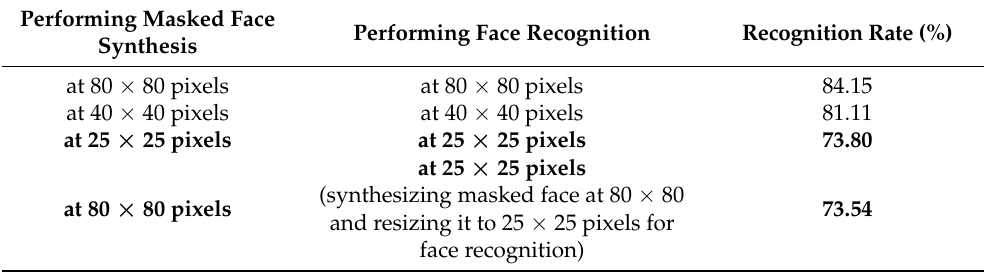
Table 2. Effect of using different facial resolutions of masked face synthesis on recognition rate. Performing Masked